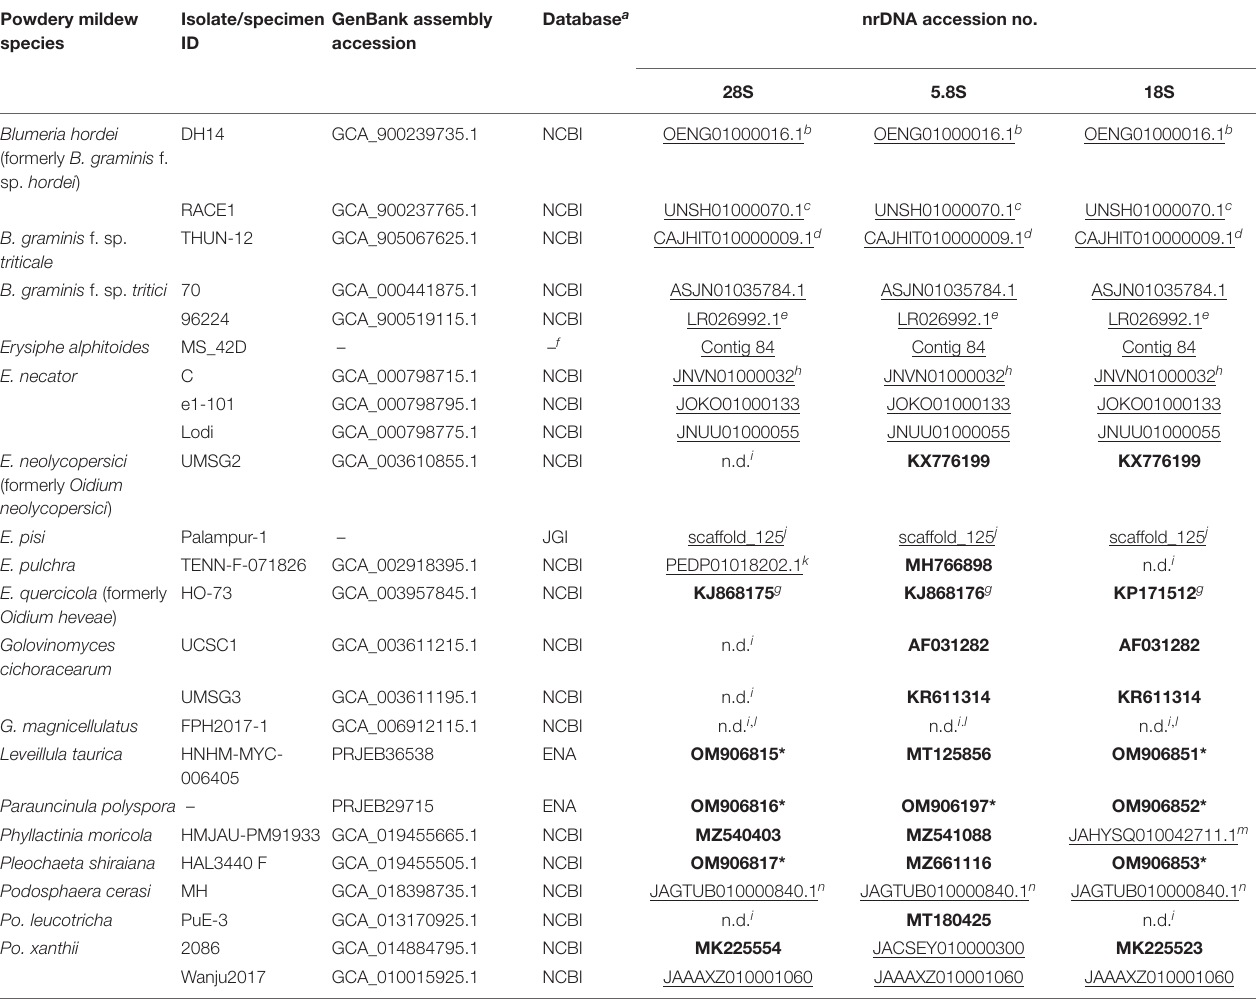
TABLE 4 | List of powdery mildew specimens included in the genome-scale and nuclear ribosomal (nrDNA) phylogenetic